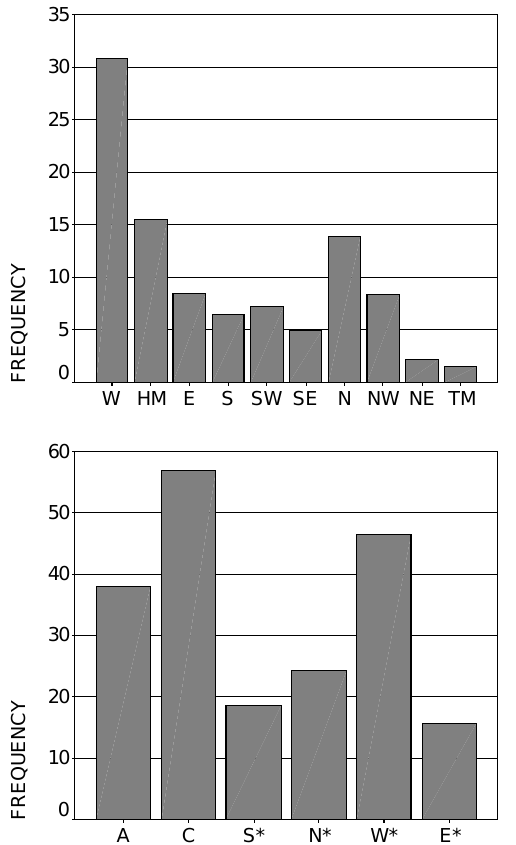
Fig. 1. Long-term mean relative frequency (in per cent) of the major types (top) and supertypes (bottom). For the notation of major types and supertypes, see Table 2.